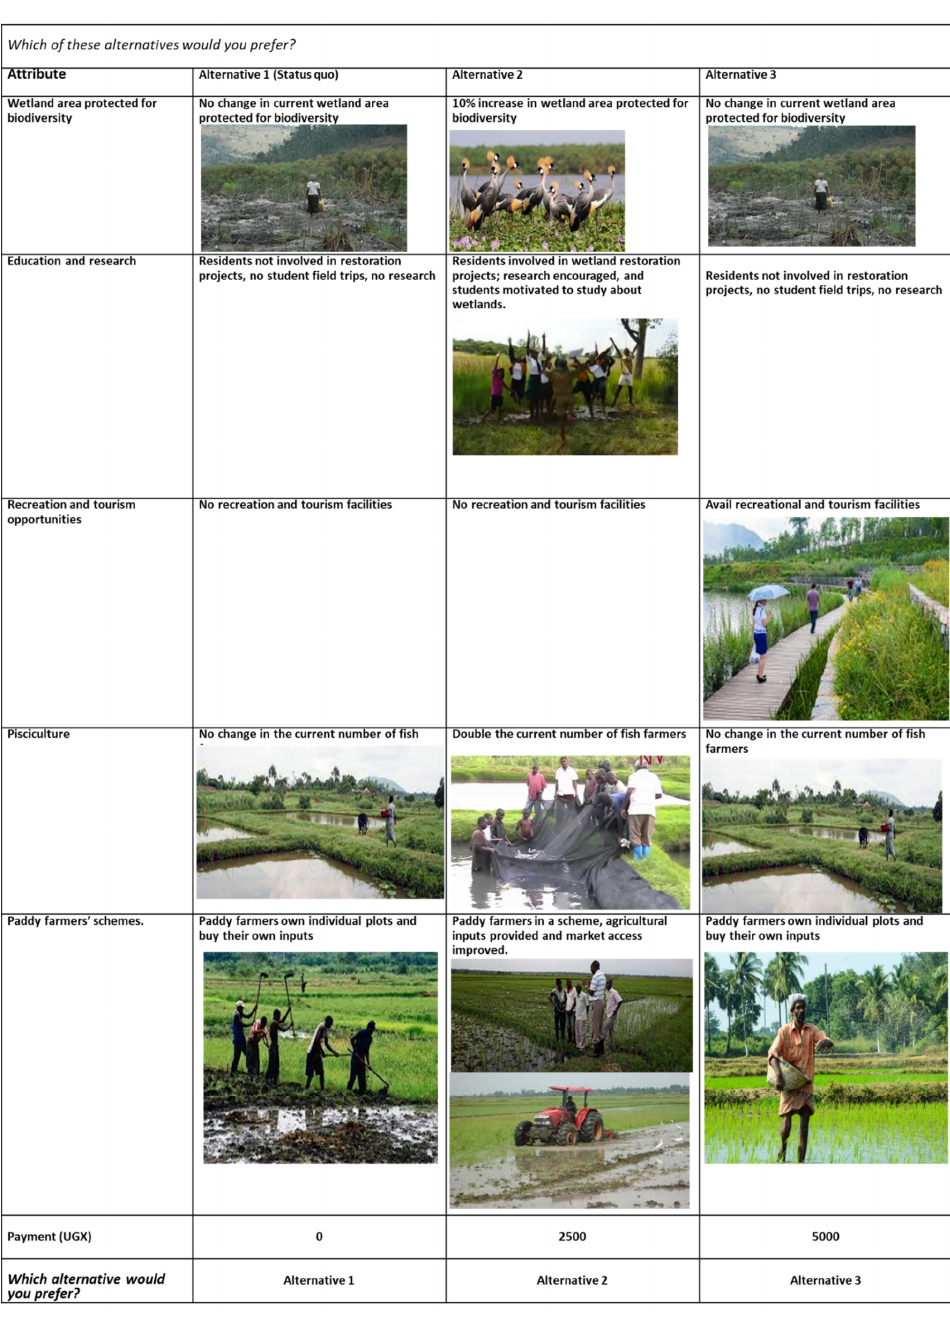
Figure 2. Sample choice card that was presented to respondents indicating the attribute and the three possible alternatives.